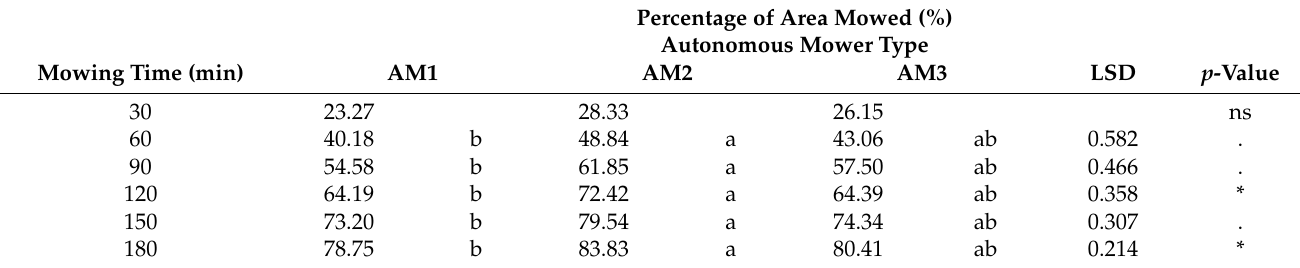
Table 2. Back-transformed mean values of the percentage of area mowed after 30, 60, 90, 120, 150 and 180 min by the three different autonomous mowers.